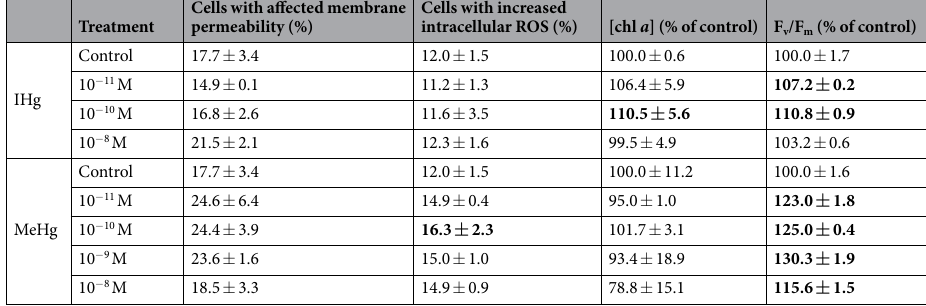
Table 2. Effects of IHg and MeHg on physiological endpoints in C. reinhardtii after 2 h exposure (bold characters indicate significantly different result from the control; t-test p -value <